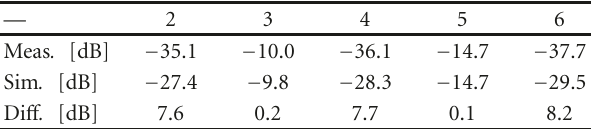
Table 7: Harmonics comparison from Figure 11. The magnitudes are related to the first